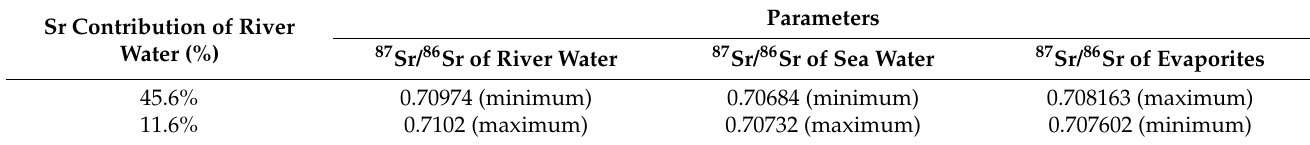
Table 3. The model calculation showing the contributions of marine and continental